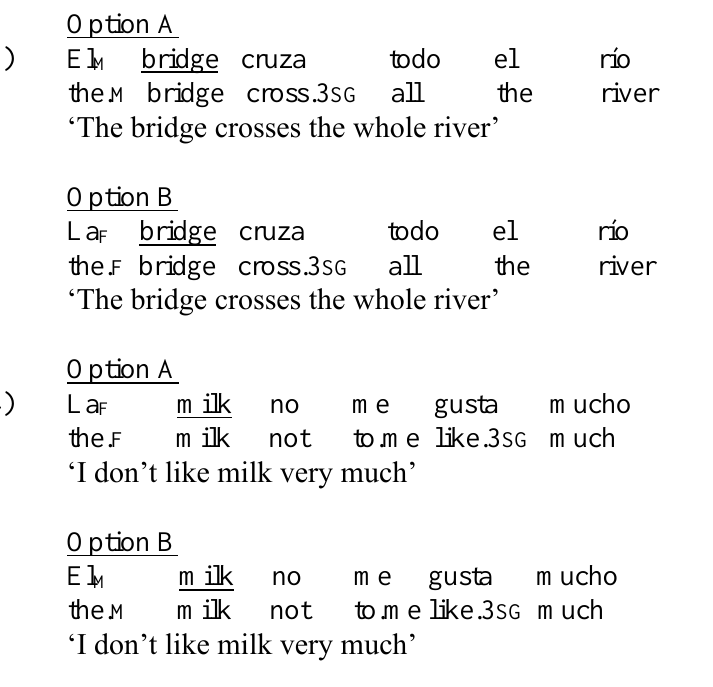
Figure 7. Results for two-alternative forced-choice judgment task Results of two-alternative forced-choice judgment